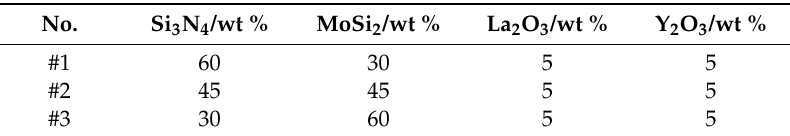
Table 2. Constituents of